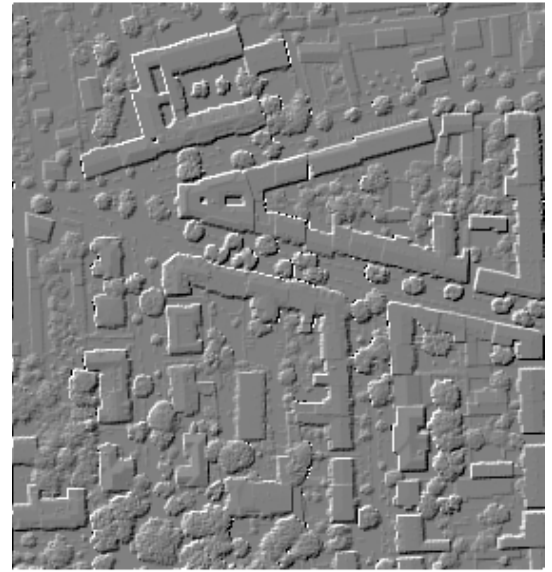
Figure 5: Digital Surface Model (DSM) of the test bed